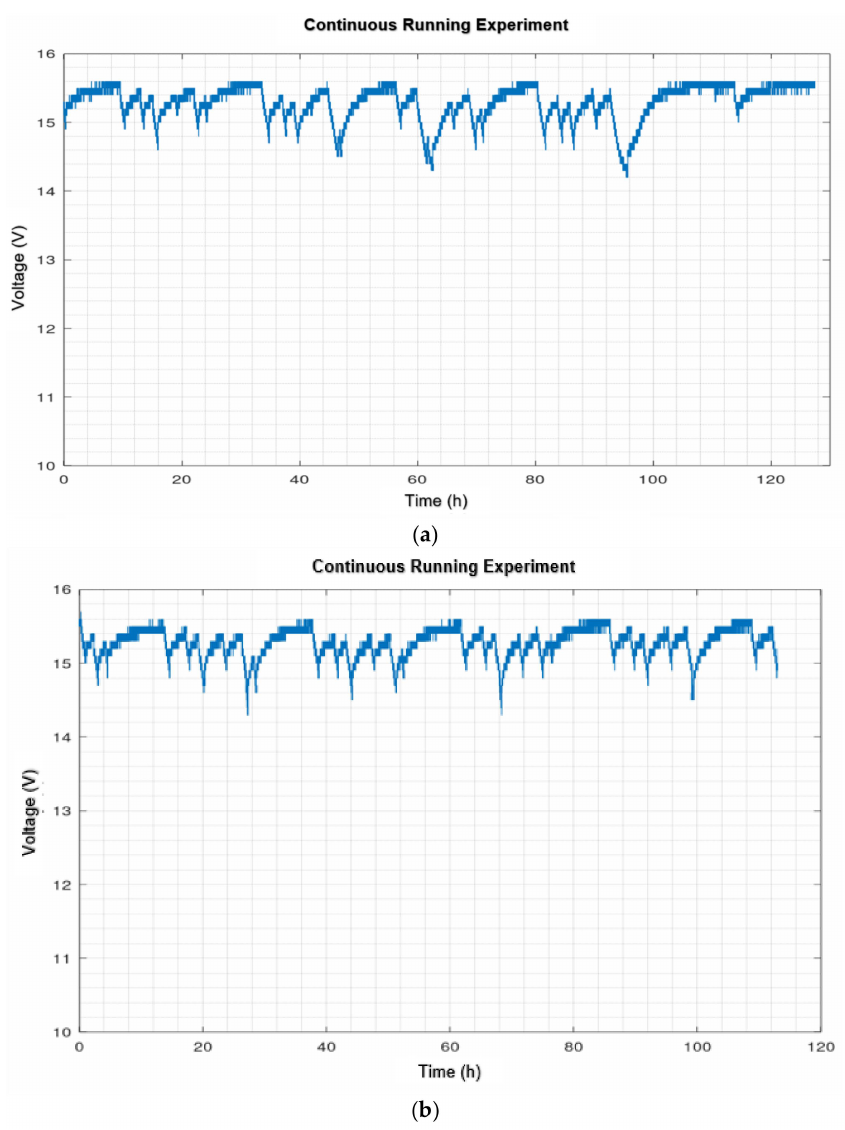
Figure 20. ( a ) First continuous operation experiment. ( b ) Second continuous operation